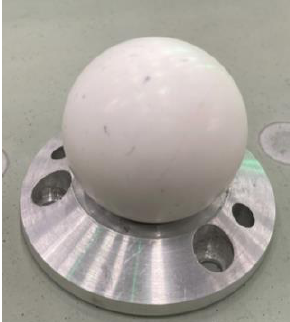
Figure 2: White spherical 1.5" laser scanner target sitting in magnetic